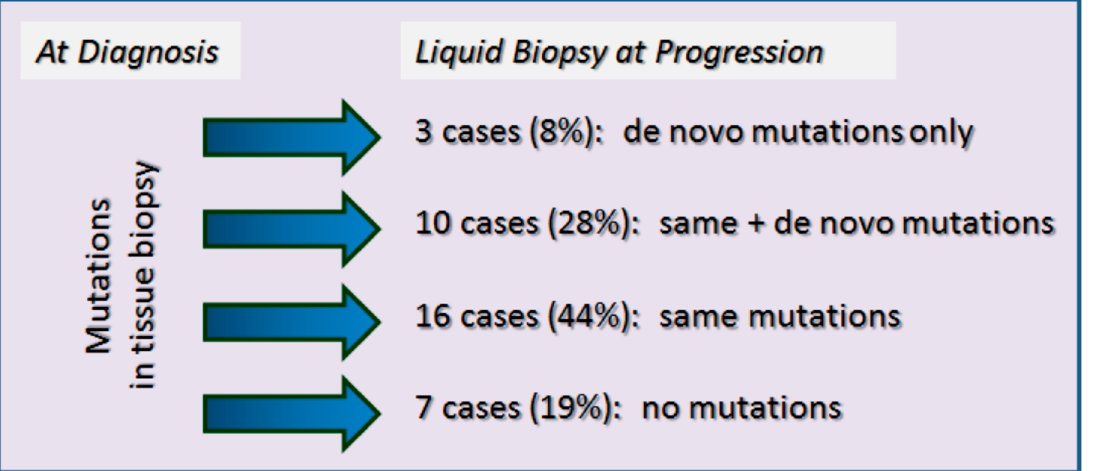
Figure 1. Summary of mutation detection in liquid biopsies of NSCLC cases at disease progression.